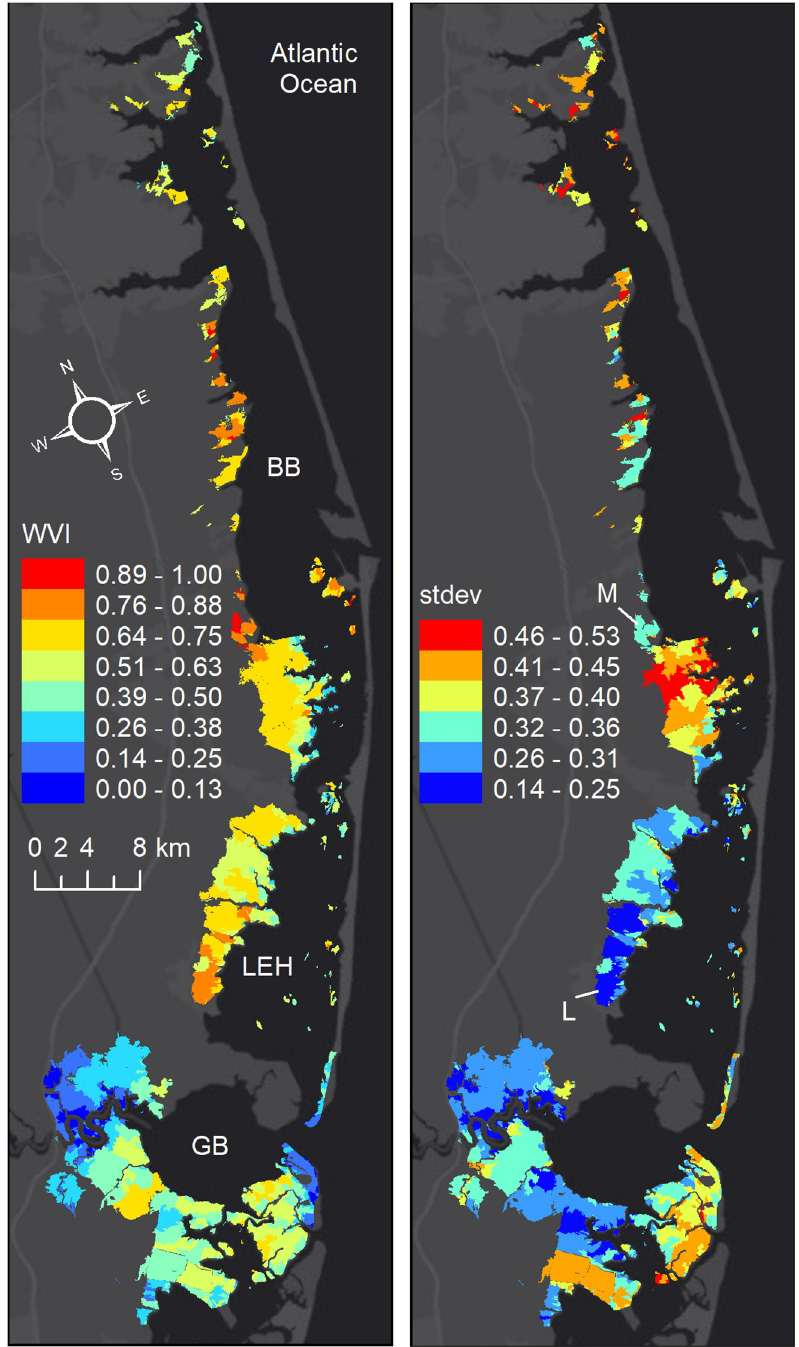
Fig 3. Wetland vulnerability index. a) Wetland vulnerability index (WVI) based on all of the data layers, and b) the standard deviation of parameters at each marsh unit (BB: Barnegat Bay, LEH: Little Egg Harbor, GB: Great Bay). L and M are two locations where vulnerability was severe, but contribution from indicators were more uniform at